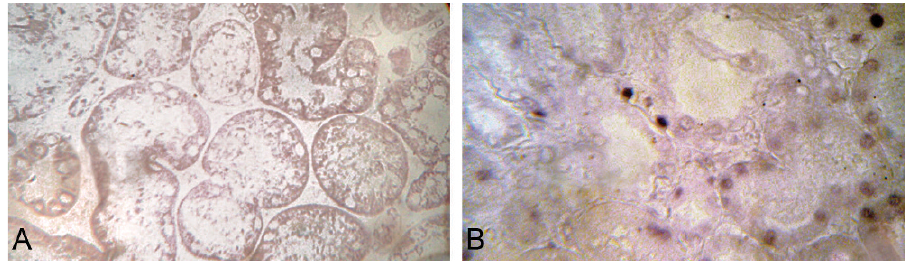
Figure 3 - Southwestern histochemistry for NF-kB expression. (A) The absence of staining and (B) moderate-to-intense staining in the tubular compartment (A and B: objective 40x).